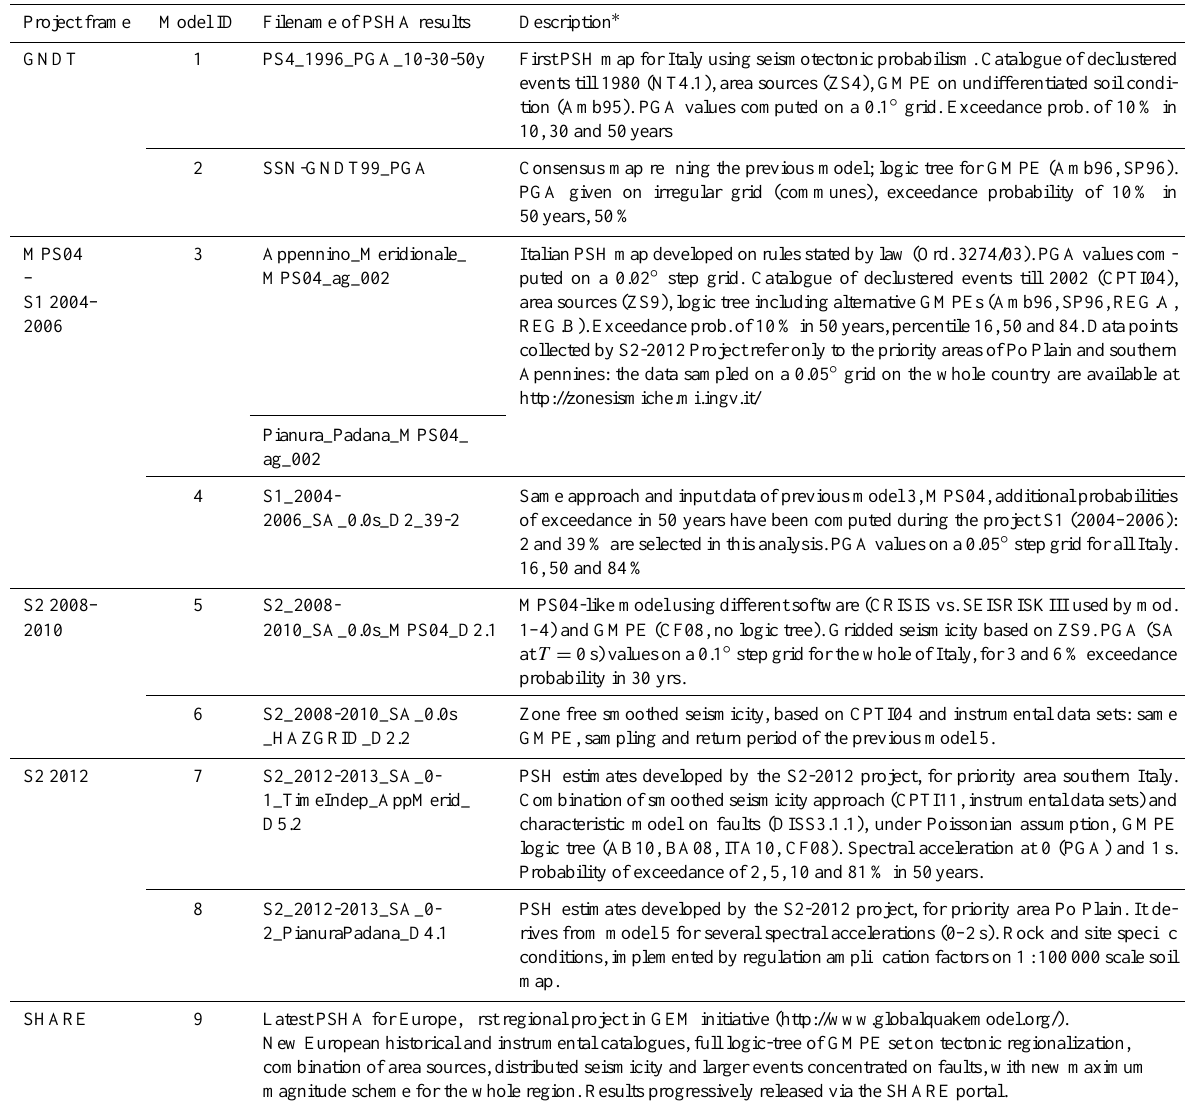
Table 1. List of selected PSHA